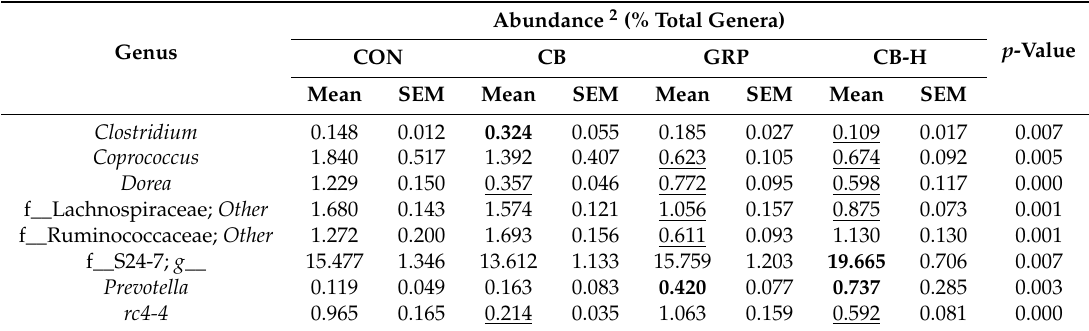
Table 5. Abundance of bacterial genera (>0.1% total) of cecal contents of rats, study 2 1 . Abundance 2 (% Total Genera) Genus